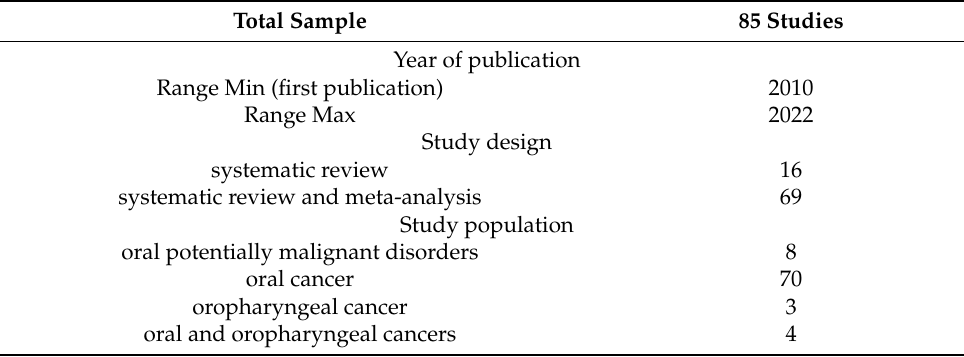
Table 1. Summarized study